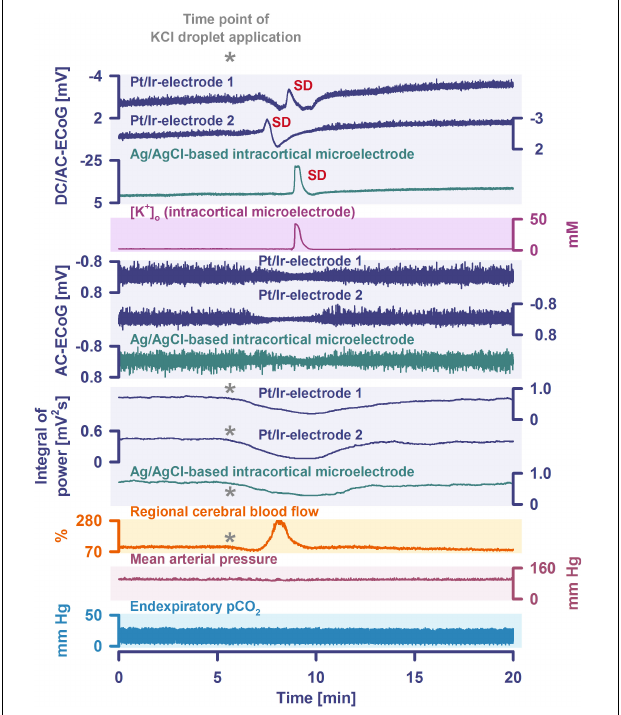
FIGURE 3 | Spreading depolarization remotely triggered by a droplet of KCl (2 M) in a naïve rat in vivo is shown. Traces 1–3: the full-band ECoG signal [DC/AC-ECoG] contains information on both the negative DC shift that identifies spreading depolarization (Dreier, 2011) and the activity changes. Note the differences in amplitude and shape of the DC shift between the gold standard recording technique in animals, the intracortical glass-microelectrode, and the platinum/iridium (Pt/Ir) electrodes on the brain surface, gold standard in humans (Dreier et al., 2017; Major et al., 2021). Also note the spread of the spreading depolarization in rostral (Pt/Ir-electrode 2)-caudal (Pt/Ir-electrode 1) direction. Trace 4: the hallmark of spreading depolarization is the near-complete breakdown of the transcellular ion concentration gradients. Here, the large spreading depolarization-associated increase in [K + ] o is seen. Traces 5–7: the spontaneous activity is assessed in the AC-ECoG, i.e., the higher frequency band between 0.5 and 45 Hz. Traces 8–10 display the integral of power of the spontaneous activity (Dreier et al., 2006, 2017). The integral of the power of the AC-ECoG is based on a method of computing time integrals over a sliding window according to a time decay function. This mathematical procedure provides a smoothed curve easing visual assessment of changes in AC-ECoG power. The method has become standard to score depression durations accompanying